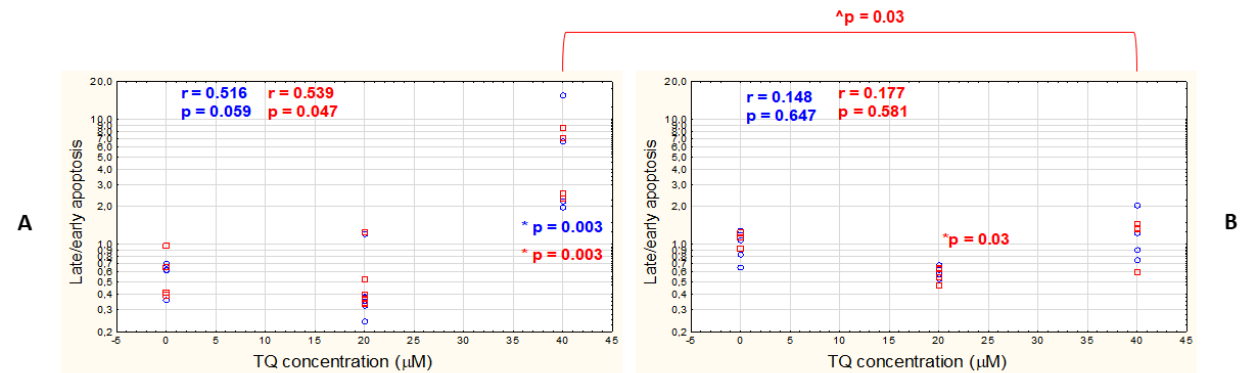
Figure 3. 40 μ M TQ increases late/early apoptotic ratio in A375 cell line, regardless of the presence or the absence of the all-caspase inhibitor. Cytometric analysis of apoptosis in A375 ( A ) and WM9 ( B ) cells incubated with different concentrations of free TQ (blue circles), or with free TQ following all-caspase inhibitor pretreatment (red rectangles). Spearman correlation analysis of the data shows the relationship between TQ concentration and late/early apoptosis ratio. Spearman correlation coefficient (r) and p -value were indicated. Data are presented as mean ± SD; * denotes significant differences in late/early apoptosis between the TQ-treated cells and DMSO control (shown as 0 µ M TQ concentration) (Mann–Whitney U test); ˆ denotes significant differences between the two analyzed cell lines (Mann–Whitney U test); all the results were considered statistically significant when p < 0.05.